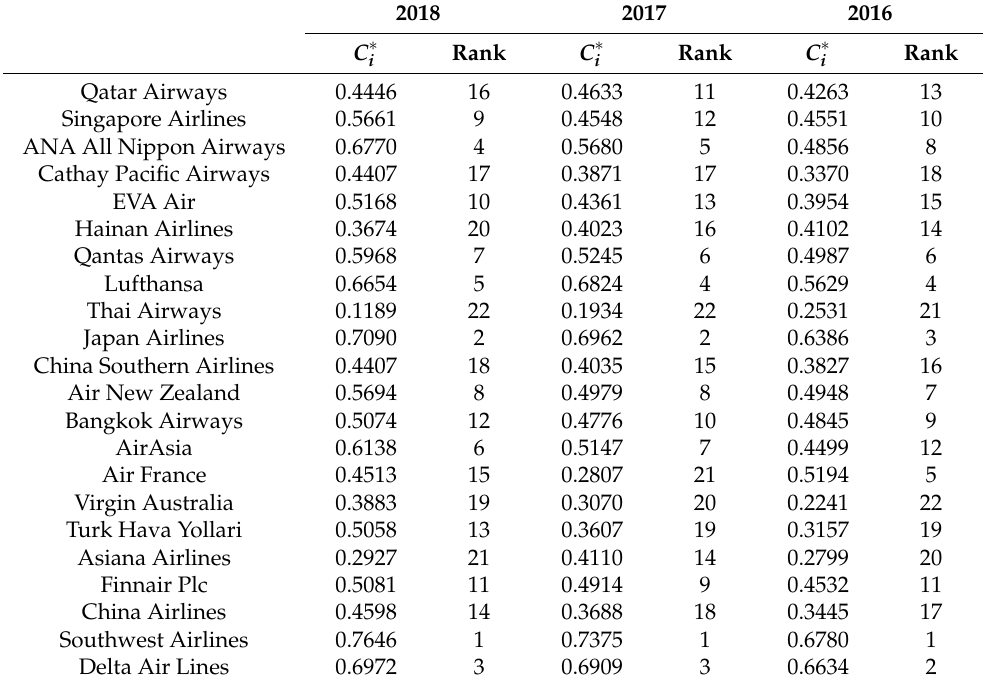
Table 6. Scores and rankings by